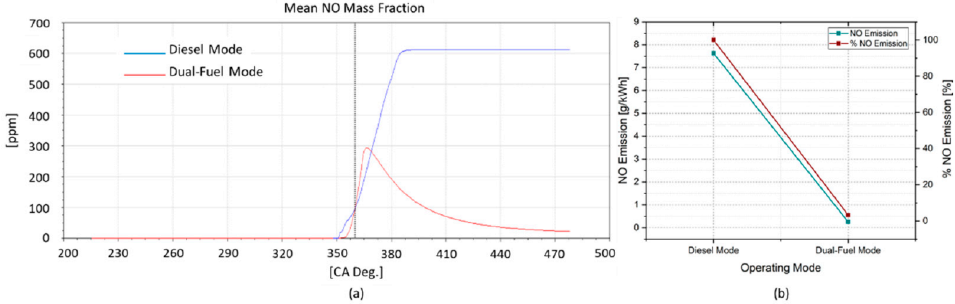
Figure 13. The mean NO mass fractions ( a ) and NO emission masses ( b ) in both combustion